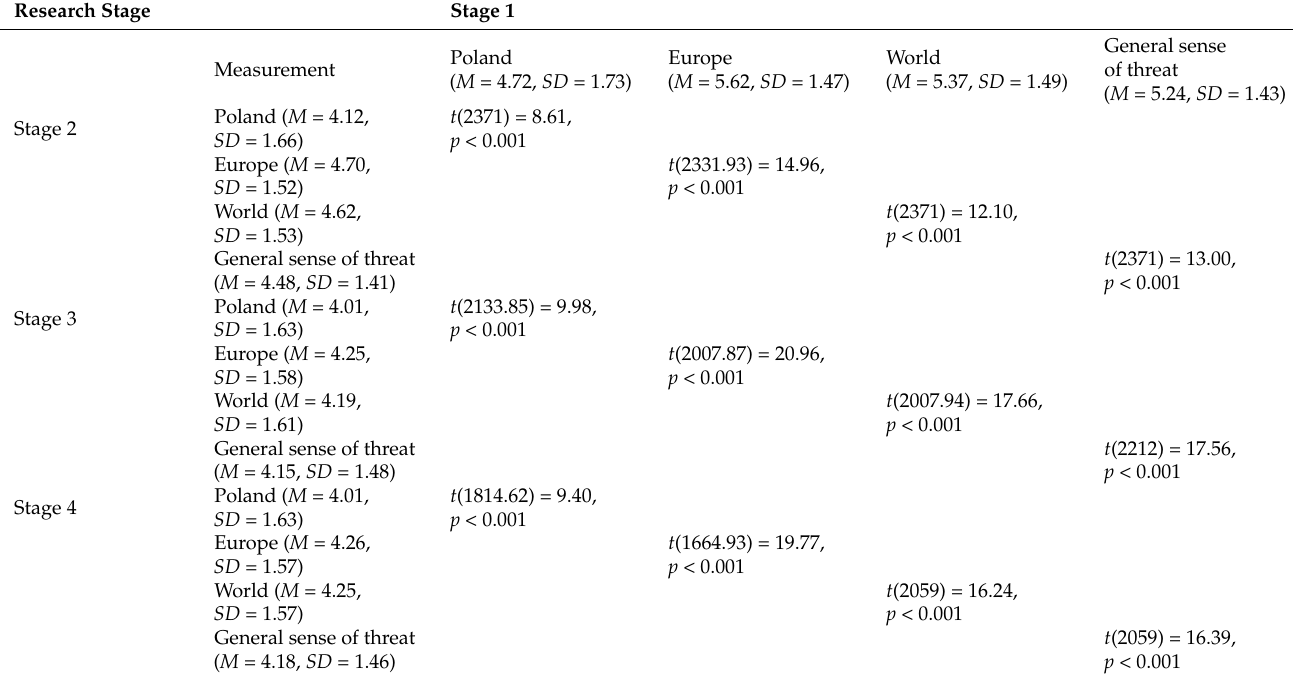
Table 2. t -test comparisons between stage 1 and the three following stages of the study. Means and SDs are presented next to the description of the